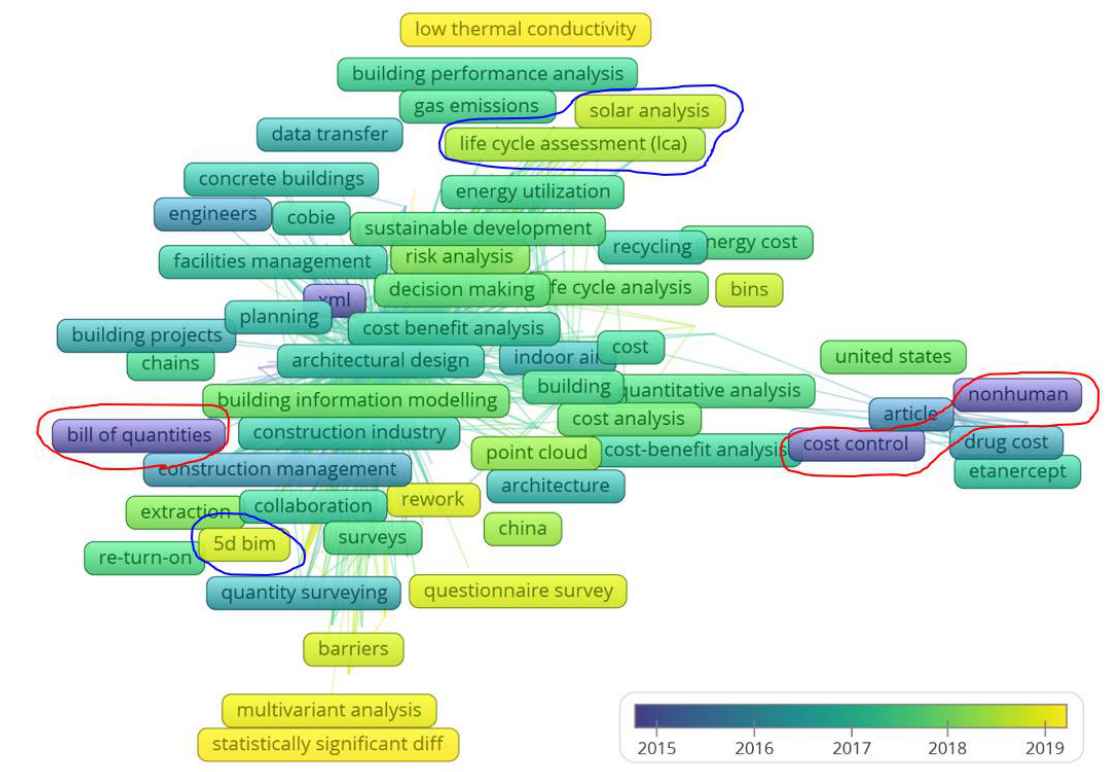
Figure 5. Co-occurrence analytical network of keywords identified from the merged CCM dataset. Note: with the minimum number of co-occurrences of 2, 1151 out of 5671 keywords are identified using the greatest total link strength.